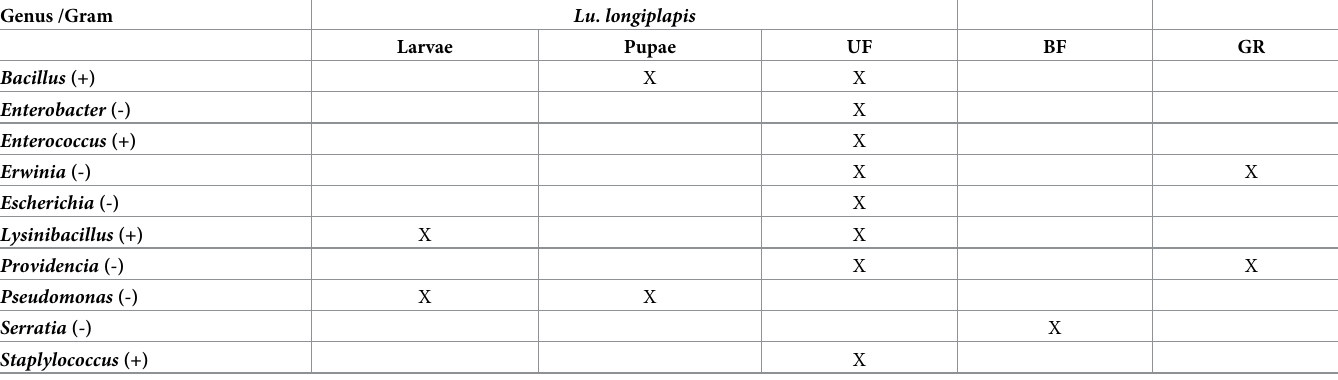
Table 1. Bacterial genera isolated from different developmental stages and physiological conditions of Lu . Longipalpis .